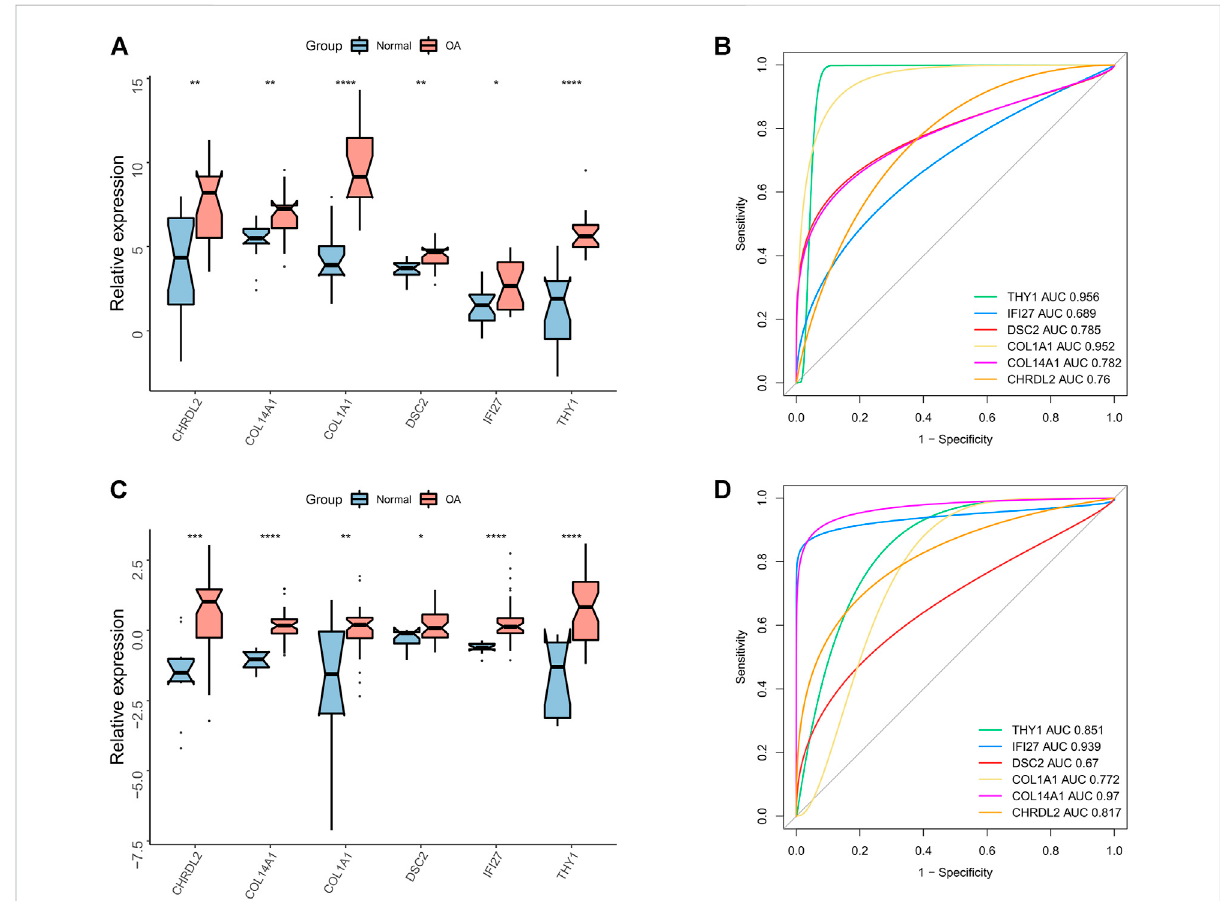
FIGURE 8 Diagnostic performance of canonical gene markers. (A) The box plots showing the expression difference between OA and normal tissues in expression of canonical gene markers in the GSE51888 dataset (* p < 0.05, ** p < 0.01, *** p < 0.001; ns, not signi fi cant); (B) ROC curve of the gene markers in the GSE51888 dataset; (C) The box plots showing the expression difference between OA and normal tissues in expression of canonical gene markers in the GSE114007 dataset (* p < 0.05, ** p < 0.01, *** p < 0.001; ns, not signi fi cant); (D) ROC curve of the gene markers in the GSE114007